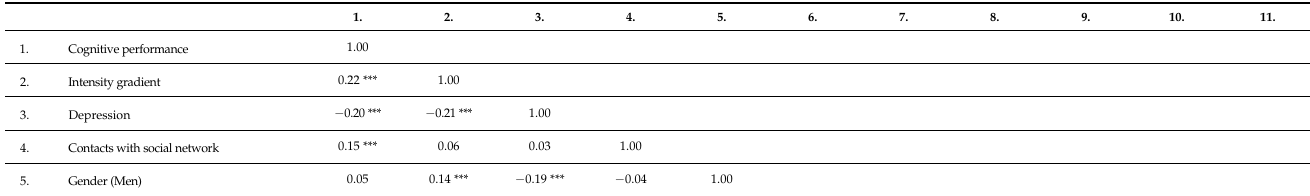
Table 2. Pearson correlations between study variables (N =